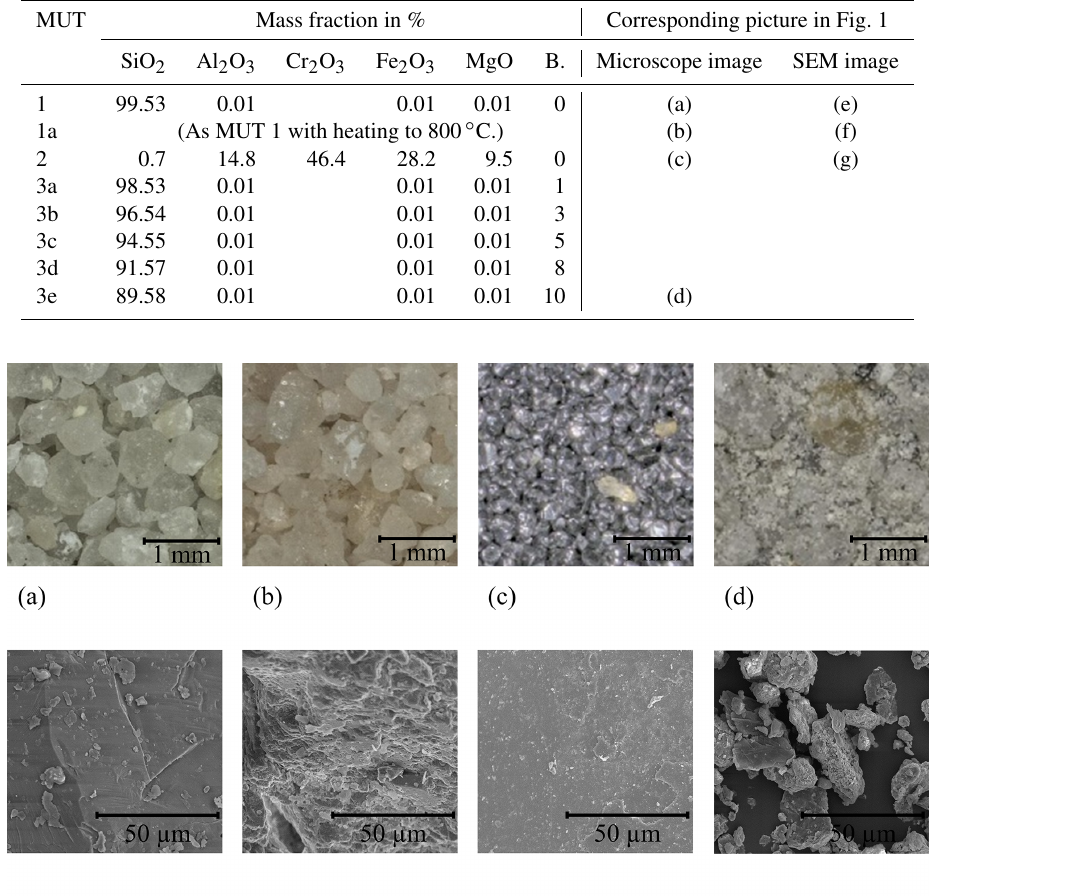
Corresponding picture in Fig. 1